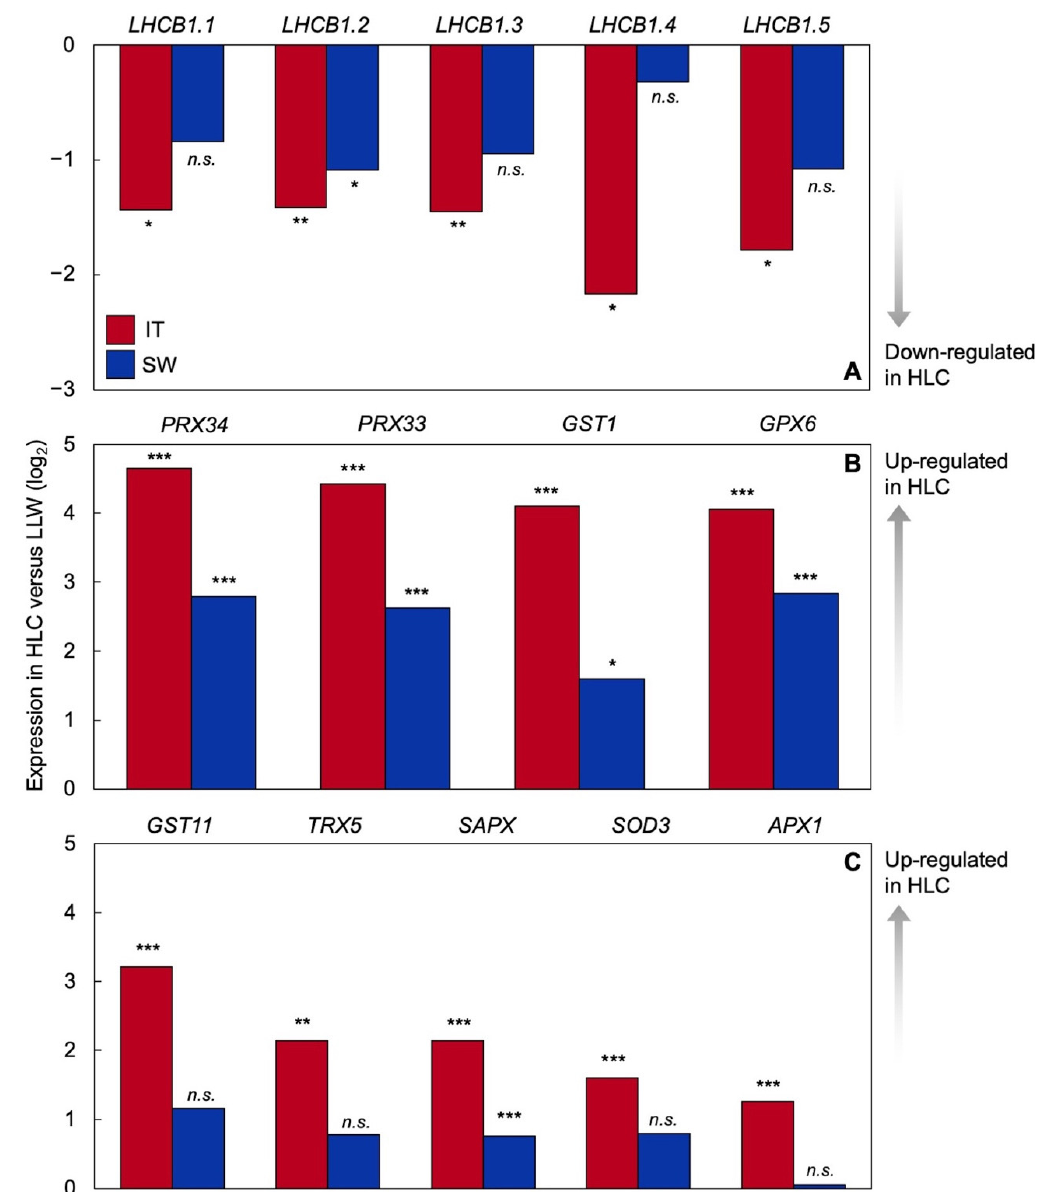
Figure 7. Gene expression patterns of either up- or downregulation in plants of IT and SW grown under high light and cold temperature (HLC) versus low light and warm temperature (LLW) for ( A ) several proteins of the light-harvesting chlorophyll ( a + b )-binding (LHCB) family, including LHCB1.1 (AT1G29920); LHCB1.2 (AT1G29910); LHCB1.3 (AT1G29930); LHCB1.4 (AT2G34430), and LHCB1.5 (AT2G34420) as well as ( B , C ), selected antioxidant enzymes, including class III peroxidases PRX33 (AT3G49110) and PRX34 (AT3G49120), glutathione S-transferases GST1 (AT1G02930) and GST11 (AT1G02920), glutathione peroxidase GPX6 (AT4G11600), cytosolic thioredoxin TRX5 (AT1G45145), stromal ascorbate peroxidase SAPX (AT4G08390) and ascorbate peroxidase APX1 (ATG07890), and iron superoxide dismutase SOD3 (AT5G23310). Significant up- or down-regula- tion between growth conditions are indicated with asterisks (* = q < 0.05; ** = q < 0.01; *** = q < 0.001); n.s. = not significantly different. Data from [52]. These findings support a proportionally greater emphasis on the mitigation of oxi- dative stress in IT as the ecotype that exhibits a lesser combined capacity for utilization (in electron transport) and pre-emptive dissipation (as heat) of excitation energy than SW